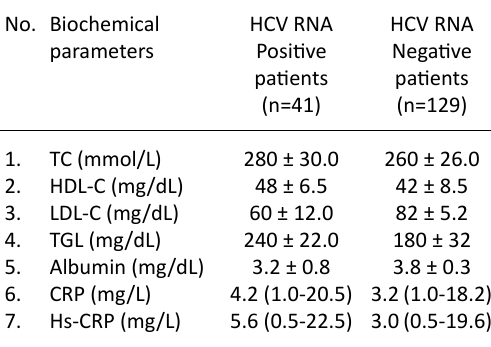
Table 2. Biochemical markers wise distribution of total HCV cases No. Biochemical HCV